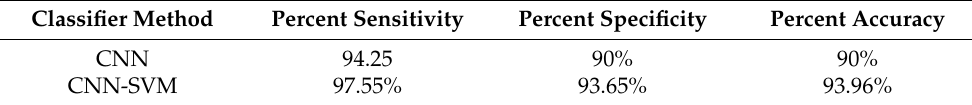
Table 4. Validation results of the testing set based on sensitivity, specificity, and accuracy.